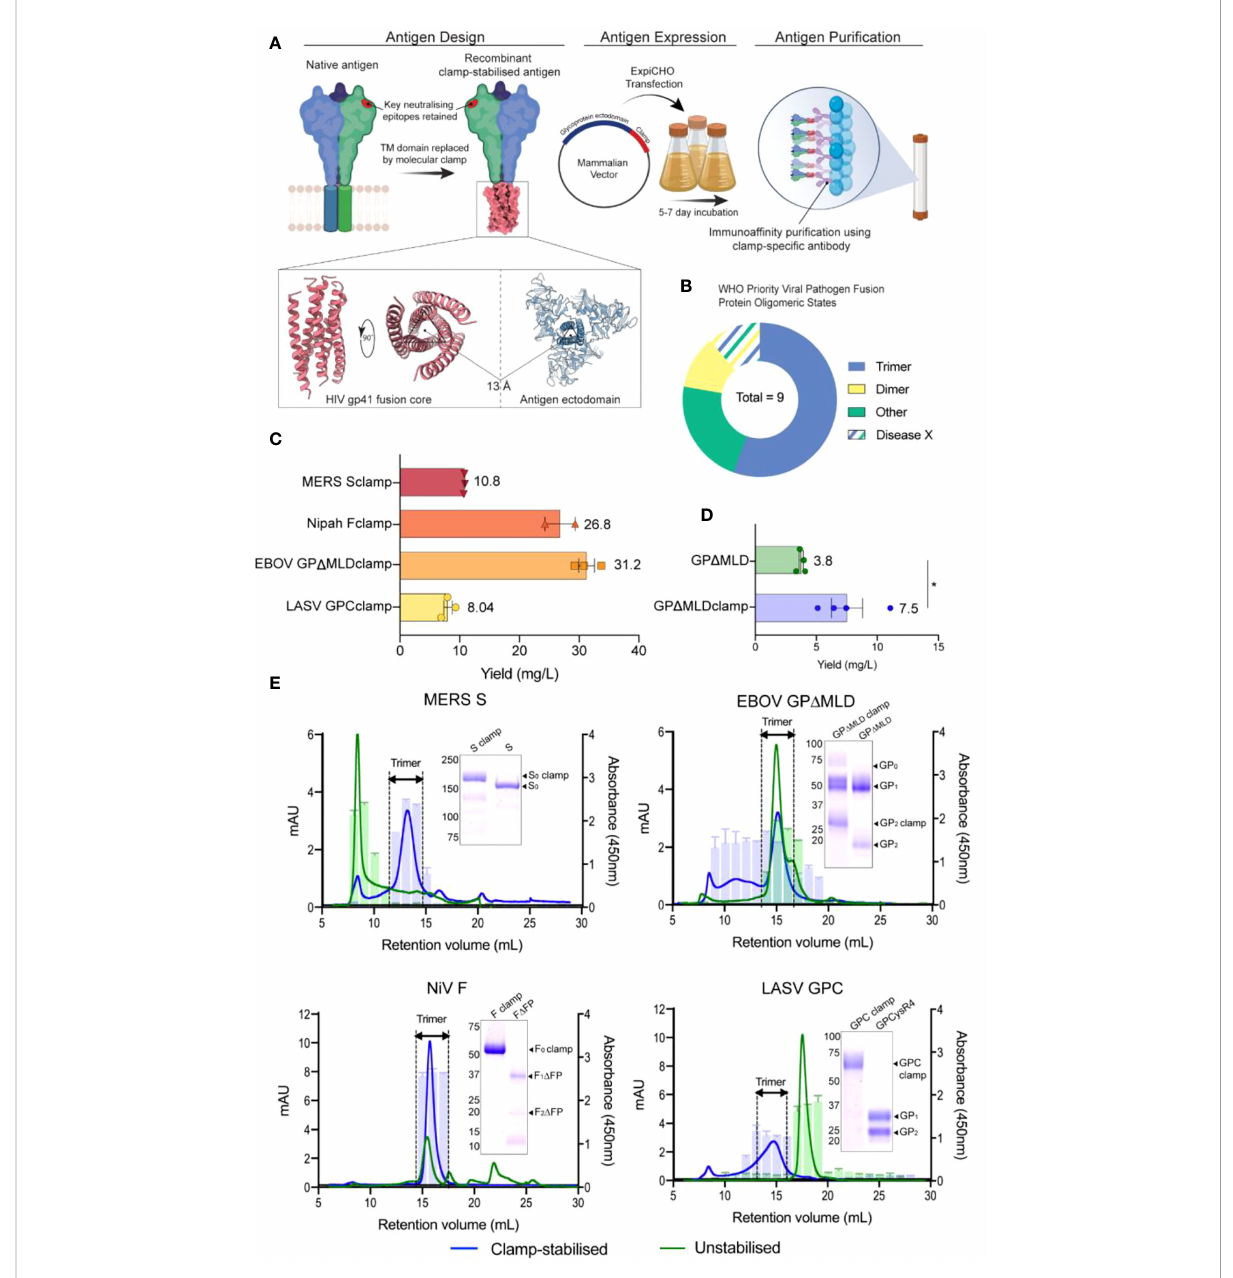
FIGURE 1 Design,generationandcharacterizationofrecombinantvaccineantigens. (A) Thevaccinecandidatesweregeneratedbygeneticallyappendingtheclamp codingregioninplaceofthenativeC-terminaltransmembrane(TM)domainsequence.Theconstructswereclonedintoamammalianexpressionvectorand expressedinExpiCHO-Scellsbeforethesecretedantigenswerepuri fi edusingclamp-mediatedimmunoaf fi nitychromatography. (B) TheWHOlist ’ spriority viralpathogensofgreatestsigni fi canceforpublichealthtofocusR&Deffortstowards.Asthemolecularclampisatrimerizationdomain,theproportionof listedvirusescontainingatrimericfusionproteinthattheclampmaybeappliedtoareshowninblue.DiseaseXrepresentsayetunknownpathogenwhich mayormaynotalsoutilizeatrimericfusionprotein.Forthefulllistsee(54). (C) TheyieldoftherecombinantantigensfromtransientCHO-Ssuspension cultureandclamp-mediatedimmunoaf fi nitychromatography.ErrorbarsshowSDfrommultipleexpressionruns. (D) Comparisonoftheyieldrecoveredfrom anti-ectodomainaf fi nitypuri fi cationusingEBOVmAbKZ52oftheclamp-stabilisedandunstabilsedGP D MLDconstructs.Theasterisk(*)indicatesstatistical signi fi cancedeterminedbyanunpaired,two-tailedttest( p =0.0267). (E) Theoligomerizationstatesoftheclamp-stabilised(blue)andunstabilised(green) antigensarepresentedassizeexclusionchromatographyUVtraces(mAU)withprefusionspeci fi cmonoclonalantibodyreactivitypresentedasbargraphs (absorbance450nm).AntibodiesusedwereKZ52forEBOVGP,37.7HforLASVGPC,5B3forNiVFand4C2forMERS-CoVS.Coomassieblue-stainedSDS- PAGEgelsofthepuri fi